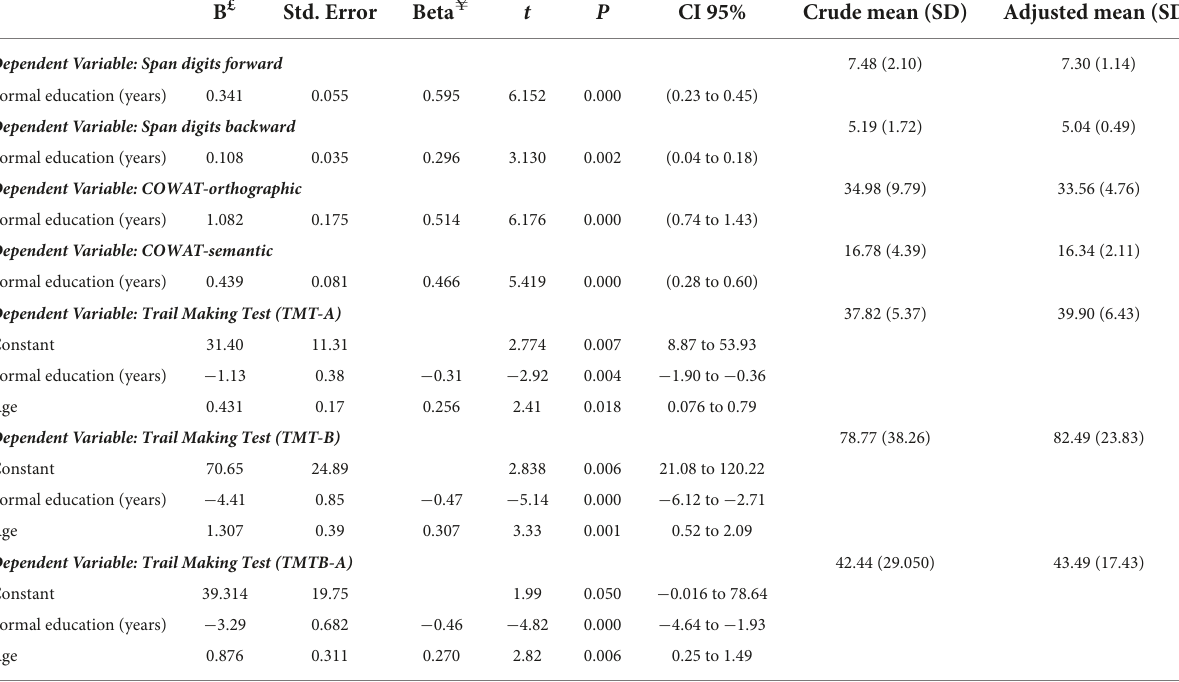
TABLE 3 Linear regression analyses to adjust the cognitive performance for years of formal education and age in FM patients. B £ Std.